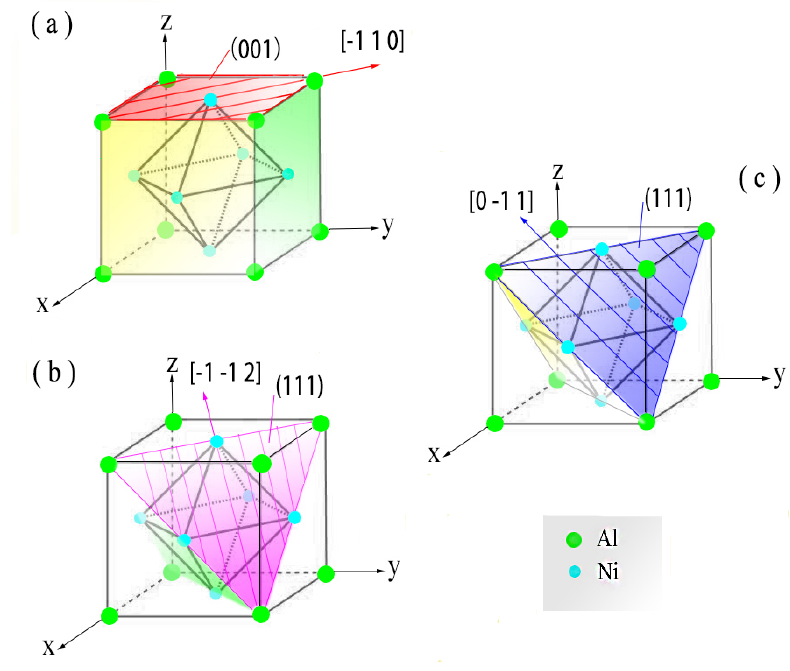
Figure 9. Slip systems illustration of the Ni 3 Al γ (cid:48) precipitates: ( a ) { 100 } < 110 > type slip system; ( b ) { 111 } < 110 > type slip system; ( c ) { 111 } < 112 > type slip